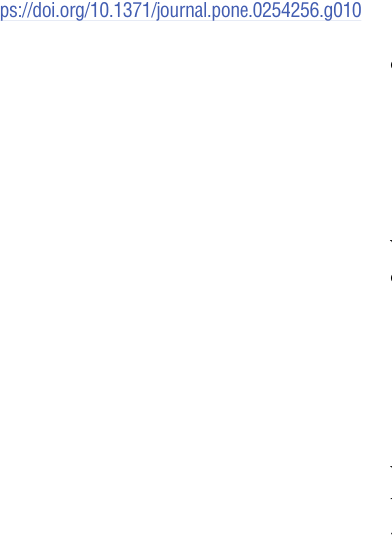
where V [ θ ] is the n th sample in the sequential samples of the wind velocity output following S n the rotation angle θ , and D [ θ ] is the wind velocity increment, i.e., the difference between two S n adjacent samples in the sequential samples V [ θ ]. Further, T [ θ ] performs a differential S n S n